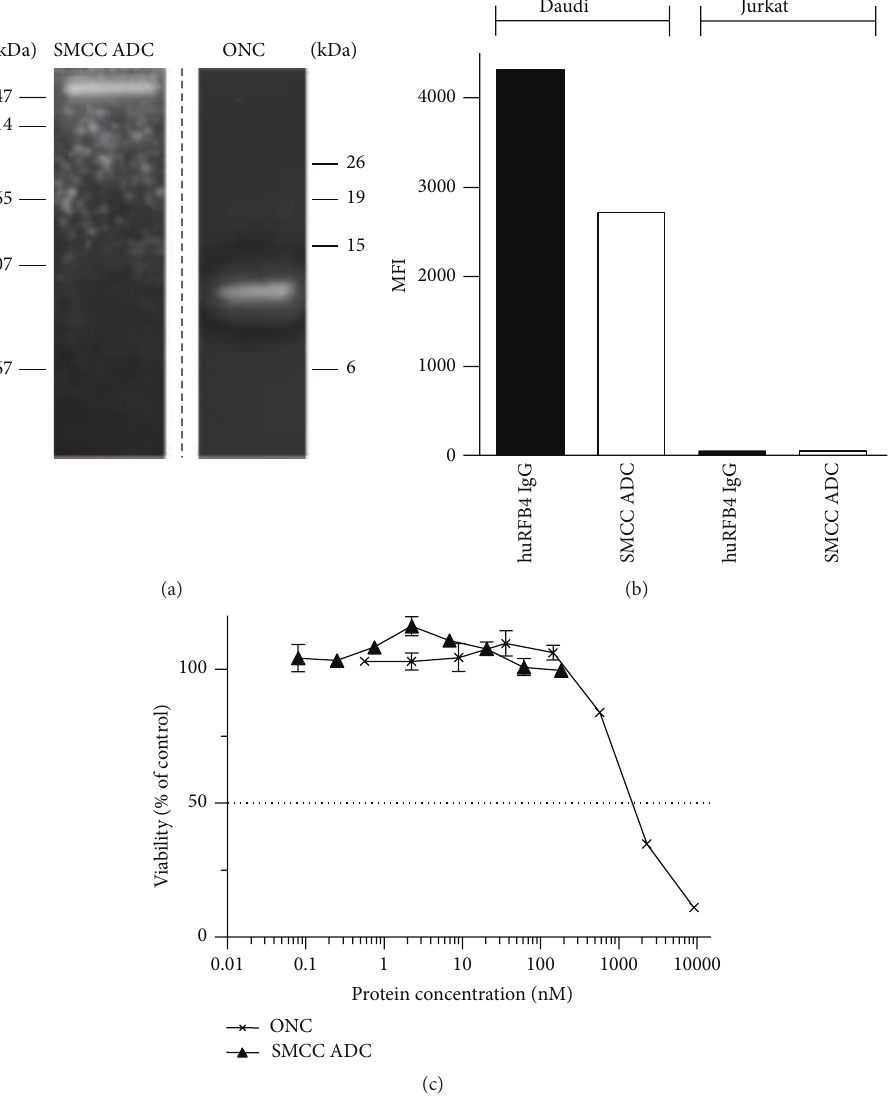
Figure 2: In vitro characterization of SMCC-based immuno-RNase ADCs. (a) In situ RNase activity of the immuno-RNase ADC (1.2 𝜇 g) and ONC alone (2.0 𝜇 g) was analyzed by zymogram gel electrophoresis on 12% SDS polyacrylamide gels containing poly-rU (0.3 mg/mL) as RNase substrate. Migration distances of molecular weight markers are indicated (kDa). (b) Binding activity of huRFB4 IgG (5 nM) and the immuno-RNase ADC (5nM) to CD22-positive Daudi cells and CD22-negative Jurkat cells is shown as median fluorescence intensity (MFI). (c) Cytotoxicity of the immuno-RNase ADC and ONC alone towards CD22-positive Daudi cells in vitro was determined by cell viability assay. Results are expressed relative to buffer-treated control cells. Data depict the mean value ± SE from one representative experiment performed in